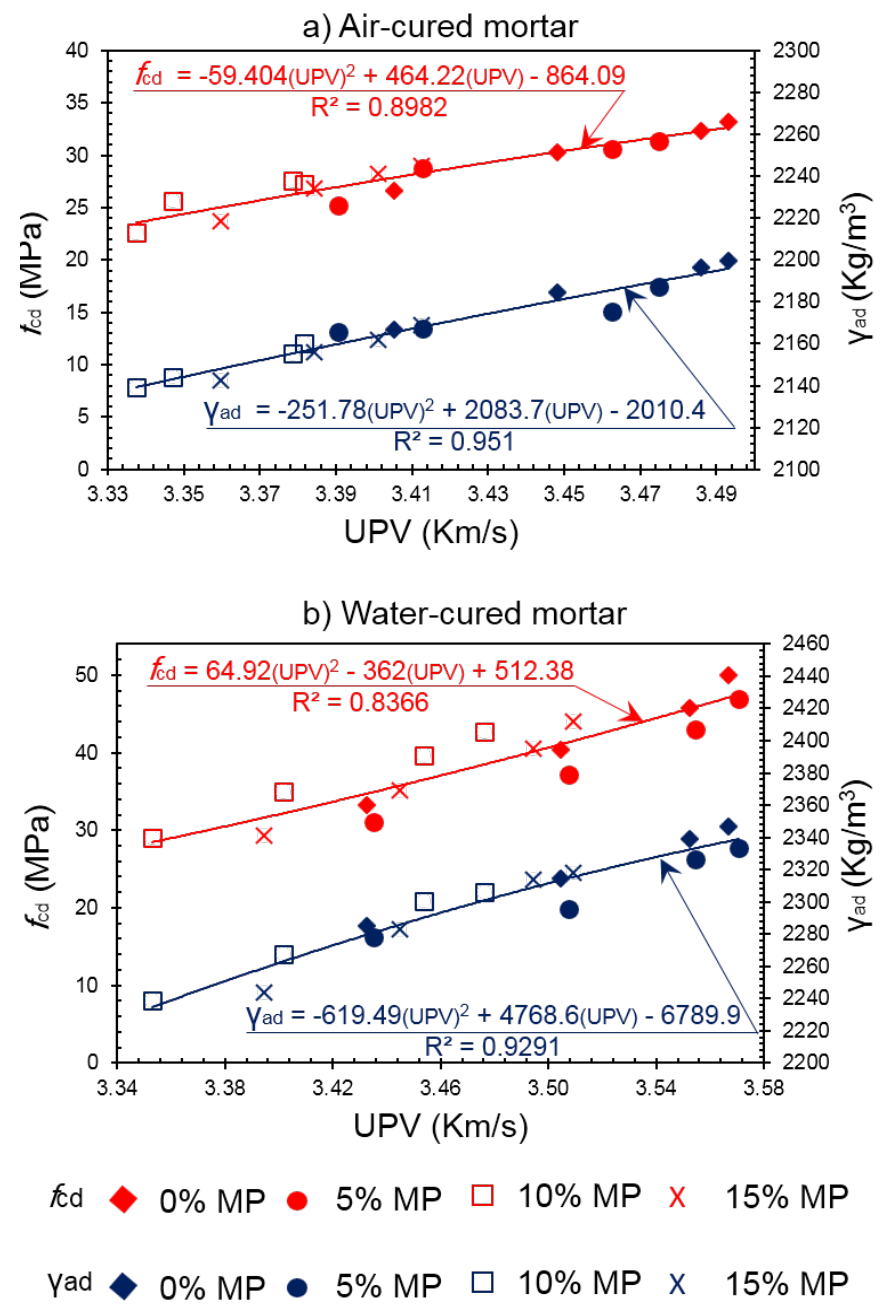
Figure 7. Relationship between compressive strength and UPV, apparent density, and UPV of mortars with increasing incorporation levels of MP, at 3 to 65 days, ( a ) air-cured mortar; ( b ) water-cured